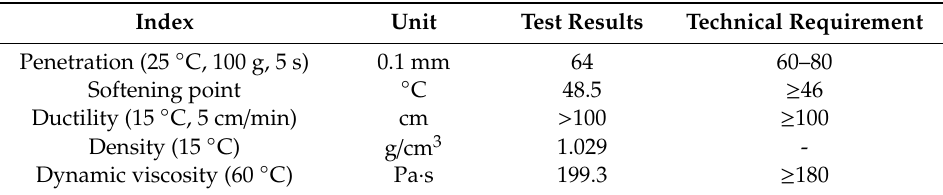
Table 1. Indexes of neat asphalt.